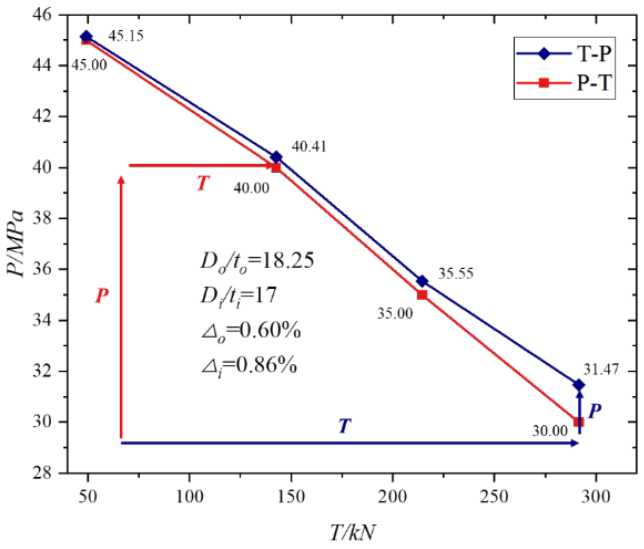
Figure 13. Collapse envelopes of different loading paths.